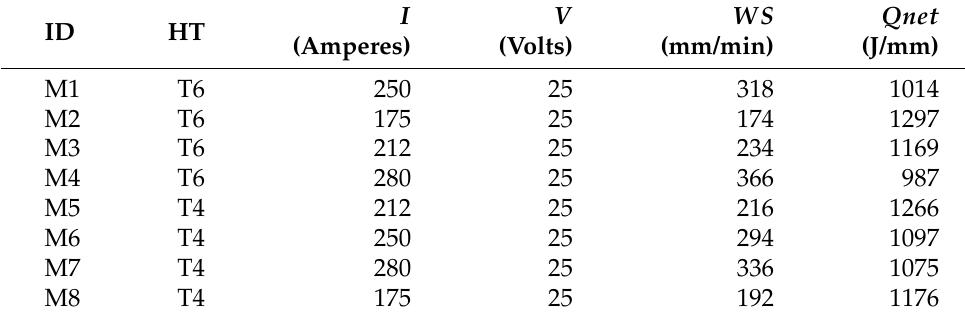
Table 2. Experimental parameters for the GMAW-P welding process.